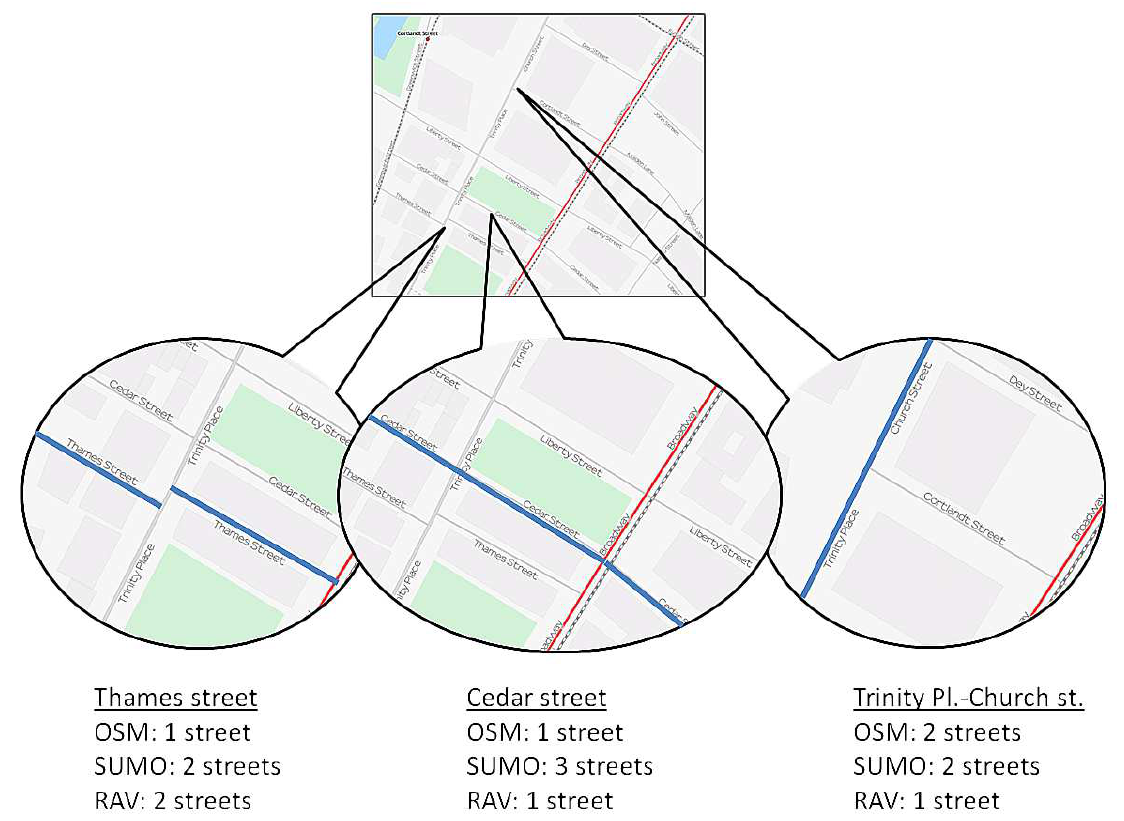
Figure 5. Different criteria when counting the number of